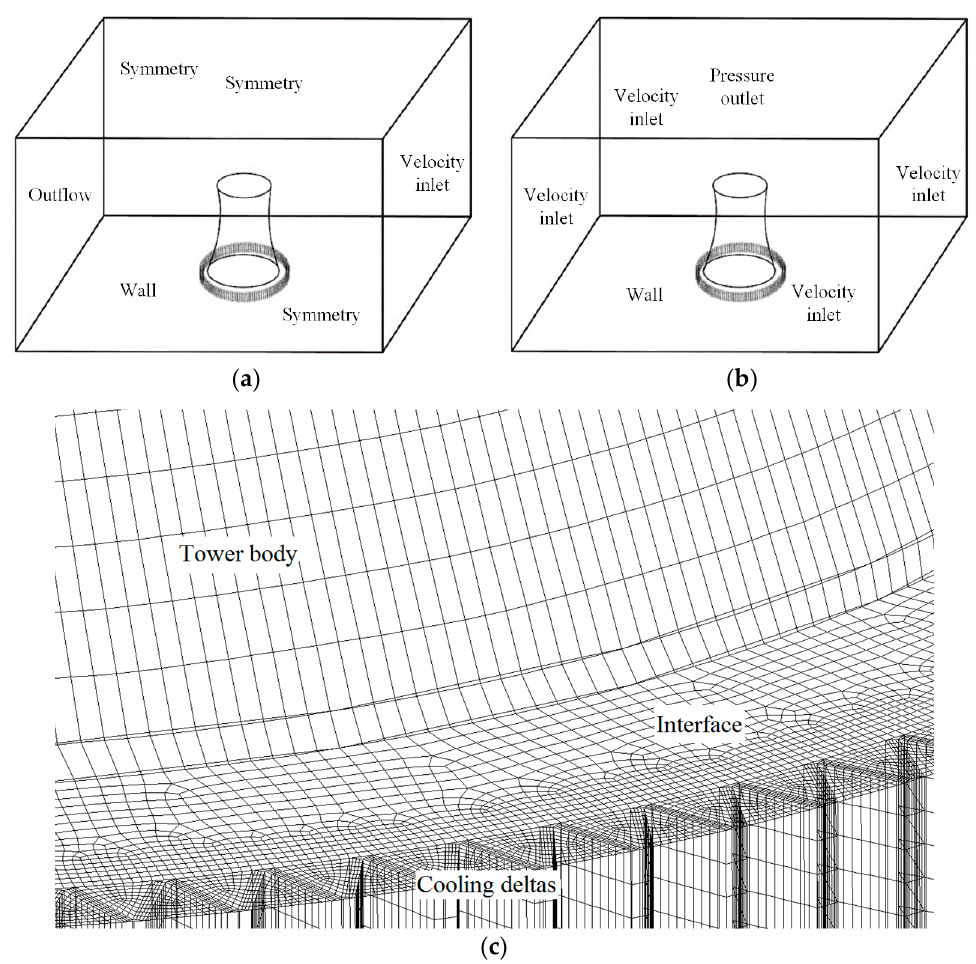
Figure 3. Computational domain, boundary, and meshes. ( a ) Computational domain and boundaries with crosswinds; ( b ) Computational domain and boundaries no crosswinds; ( c ) multi-block meshes.